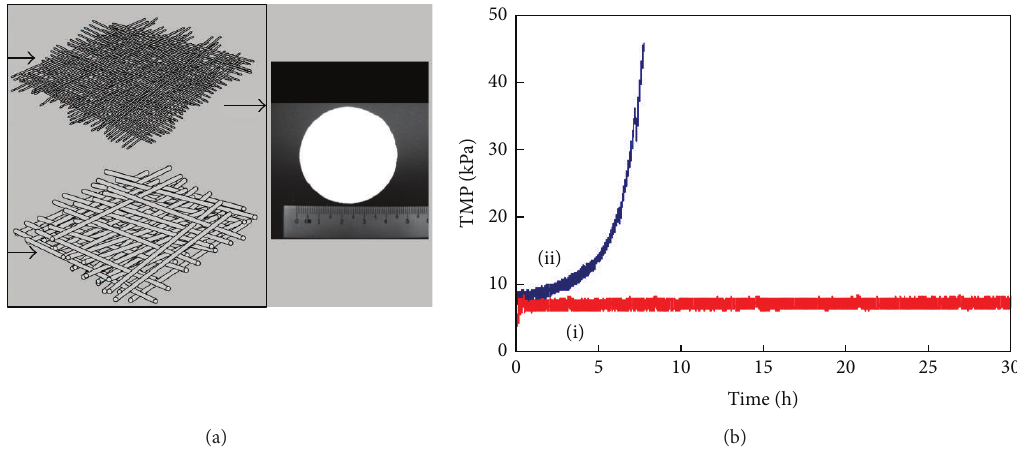
Figure 8: (a) TiO 2 nanowire membrane. (b) The transmembrane pressure change of TiO 2 nanowire membrane during filtration: (i) with UV irradiation and (ii) without UV